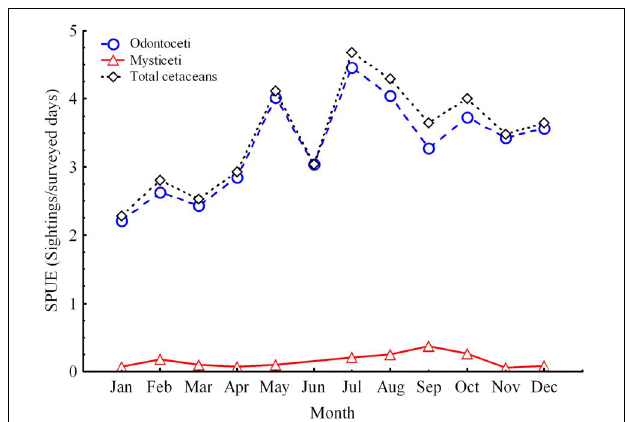
FIGURE 3 | Temporal variation of total cetacean sightings per unit effort (SPUE; sighting/surveyed days) in the Canary Islands during the study period (Jan. 2007–Dec. 2018). Black line: Total cetacean sightings; blue line: Odontoceti; red line: Mysticeti.